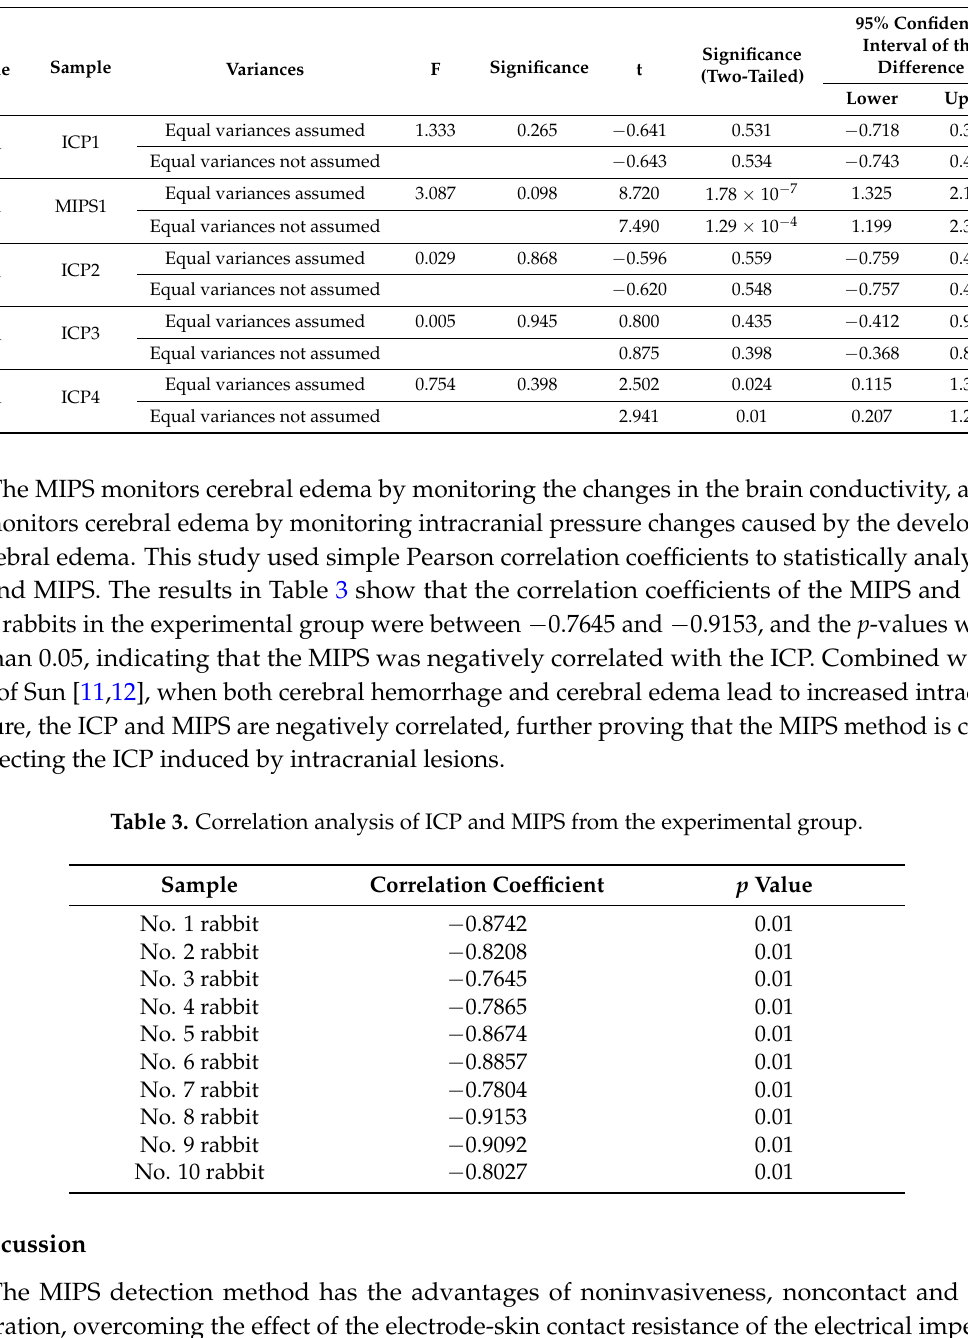
Table 2. Independent t -test of ICP and MIPS from experiment group and control group.